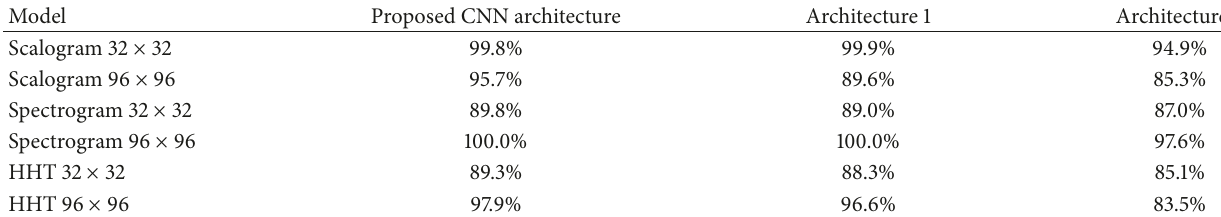
Table 12: Specificity for MFPT data set.